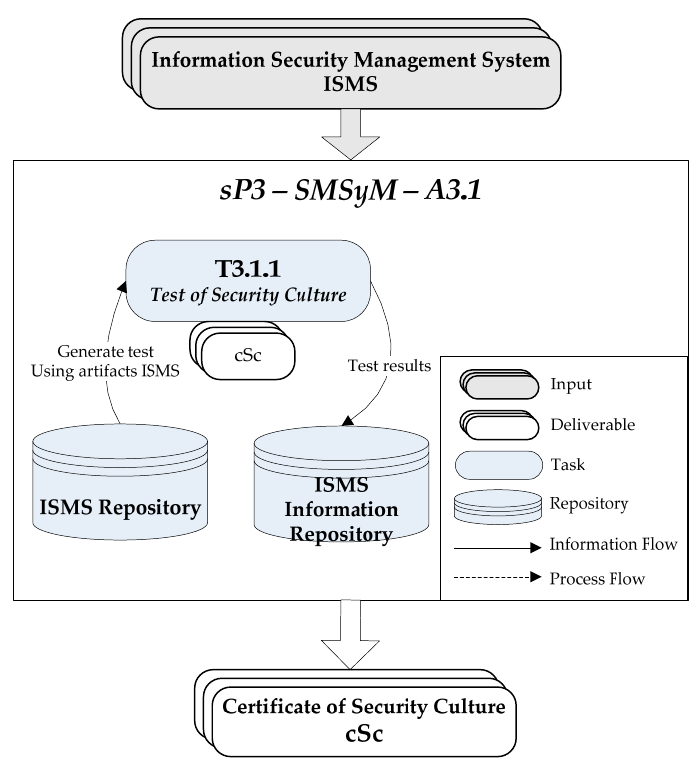
Figure 4. Detailed schema of the task in Activity A3.1.